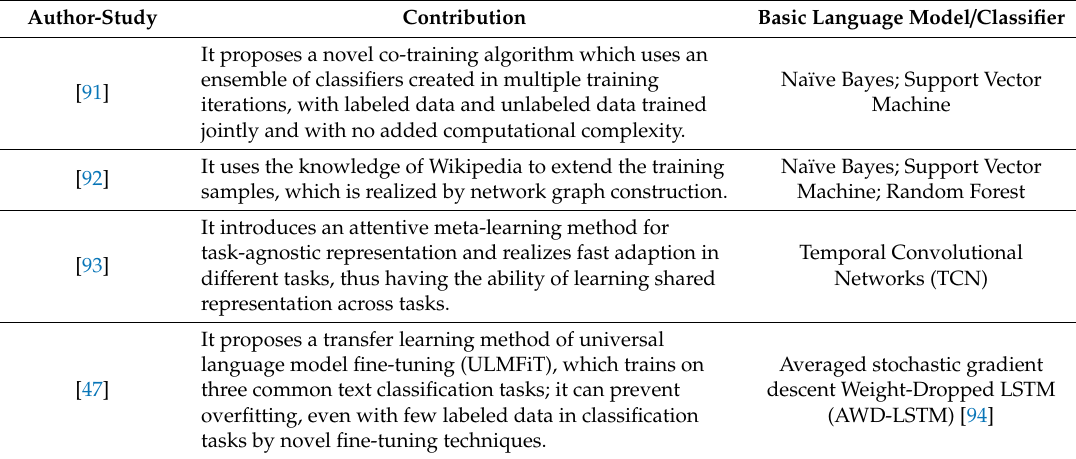
Table 3. Strategies of few in-domain labeled data in